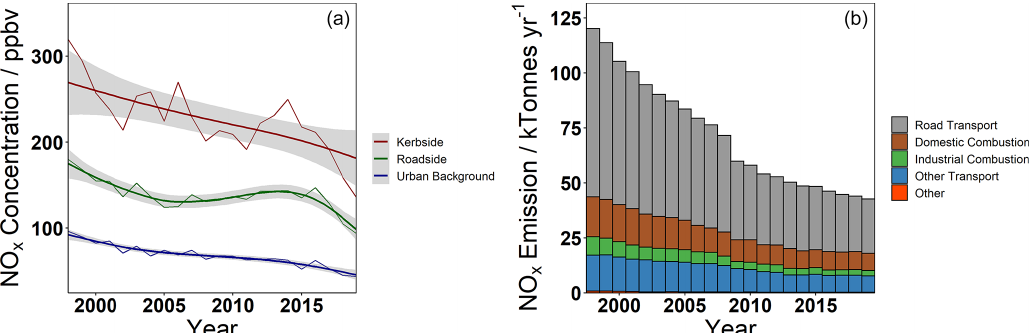
Figure 2. (a) Change in average concentration at roadside, kerbside, and background sites in Greater London between 1998 and 2019. All sites with available data were first annually averaged, followed by calculating the grand mean of all sites of a given type per year. A generalised additive model (GAM) was fit to the data to produce the smooth line, and shading shows the standard error in this fit. (b) NAEI emissions for Greater London. As historical spatially resolved versions of the NAEI are not available, these data were generated by scaling each sector of the spatially resolved inventory for 2019 within the Greater London area by their relative value in the historical UK total emissions data. This assumes that London has generally followed the UK trend in NO x